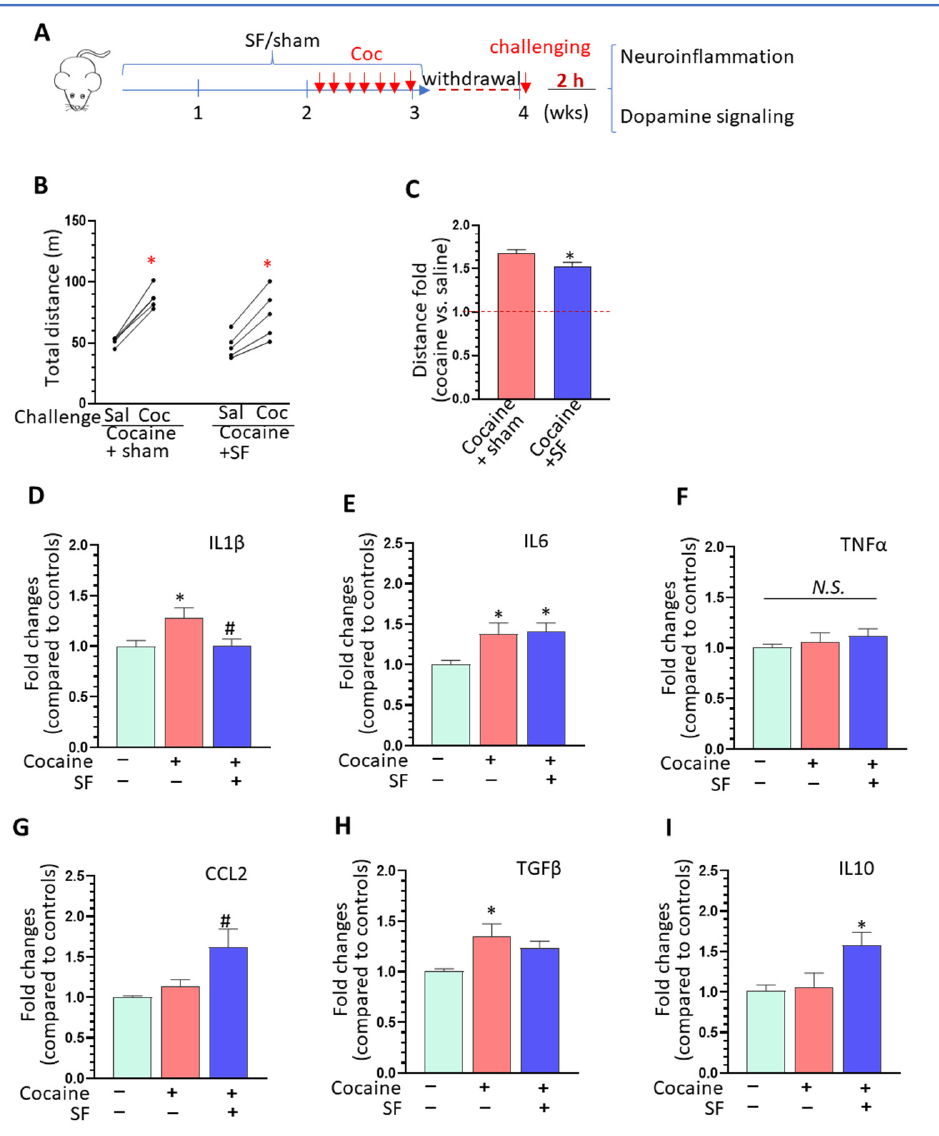
Figure 6. Effects of SF on cocaine-mediated locomotion sensitivity and neuroimmune signaling in withdrawn mice. ( A ) Schematic for the experimental design. ( B ) Challenging with